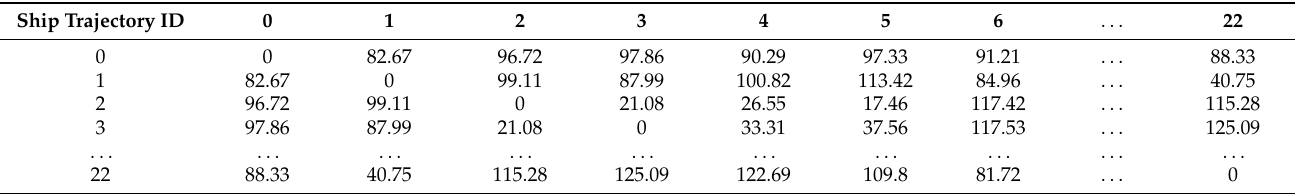
Table 4. Similarity matrix of ship trajectories from Kaohsiung Port to Xiamen Port. Ship Trajectory